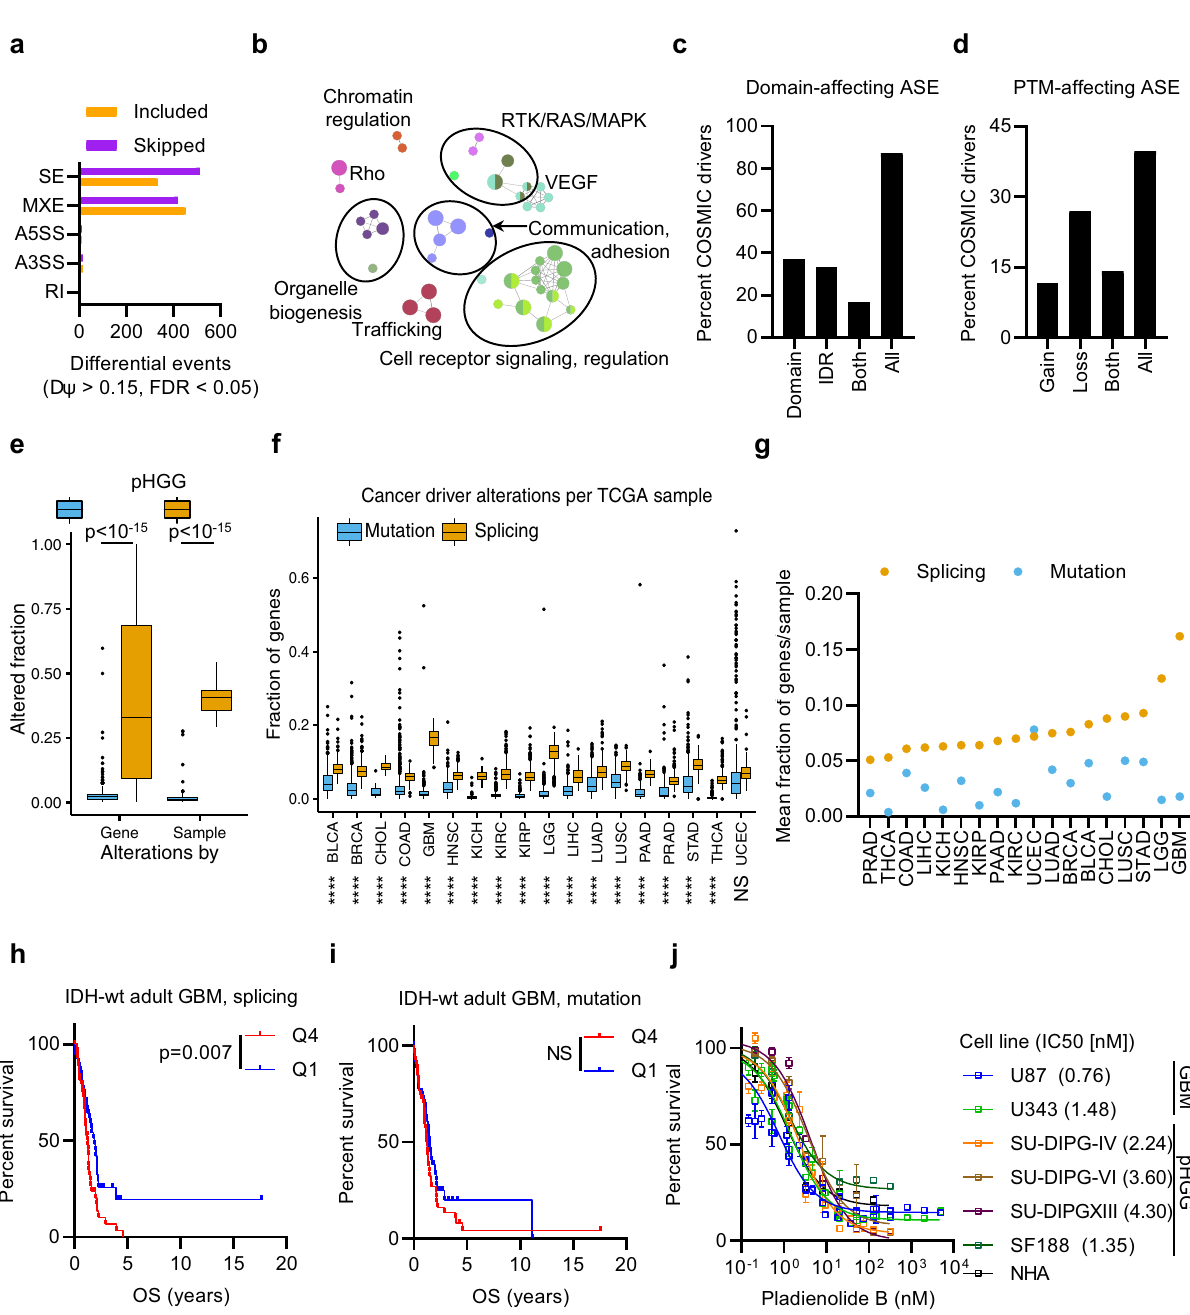
Fig. 2 Pan-cancer alternative splicing converges on cancer-driver genes. a The number of differential ASE that are preferentially included or skipped in pHGG from each ASE category. SE skipped exon, MXE mutually exclusive exon, A5SS alternative 5 ’ splice site, A3SS alternative 3 ’ splice site, RI retained intron (see Supplementary Fig. S2a for schematic). b Reactome pathways enriched among genes differentially spliced in pHGG at false discovery rate (FDR) < 0.05. c Percentage of COSMIC cancer-driver genes with differential ASE predicted to affect structural domains or intrinsically disordered domains (IDR) mapped in UniProt. d Percentage of COSMIC cancer-driver genes with differential ASE predicted to affect post-translational modi fi cation (PTM) sites mapped in UniProt. e Burden of splicing and mutations among COSMIC cancer-driver genes in pHGG ( n = 51). The left group (Gene) shows the fraction of samples with an alteration per driver gene. The right group (Sample) shows the fraction of driver genes that are altered per sample. The box marks the interquartile range (IQR) and shows the median value. The whiskers extend to 1.5× IQR and outliers outside this are plotted separately. f Pan- cancer burden of splicing and mutations in COSMIC cancer-driver genes, showing the fraction of driver genes that are altered per sample. The box marks the interquartile range (IQR) and shows the median value. The whiskers extend to 1.5× IQR and outliers outside this are plotted separately. See Supplementary Data 4 for n and P values. g Data in ( f ) are summarized to show the mean fraction of altered genes per sample across each tumor type. h Kaplan – Meier survival plot of IDH-wt GBM patients that are in the top (Q4, n = 55) or bottom (Q1, n = 57) quartile of splicing burden of cancer-driver genes. i Kaplan – Meier survival plot of IDH-wt GBM patients that are in the top (Q4, n = 55) or bottom (Q1, n = 56) quartile of mutation burden of cancer- driver genes. j Cell lines were treated with increasing concentration of pladienolide B for 5 days and viability was measured with alamarBlue ( n = 6). Bars show mean ± standard error. Statistical tests: t ( e ) with Benjamini – Hochberg multiple hypothesis testing correction ( f ), log-rank ( h , i ). **** P < 0.0001. NS not signi fi cant. Source data are provided as a Source Data fi